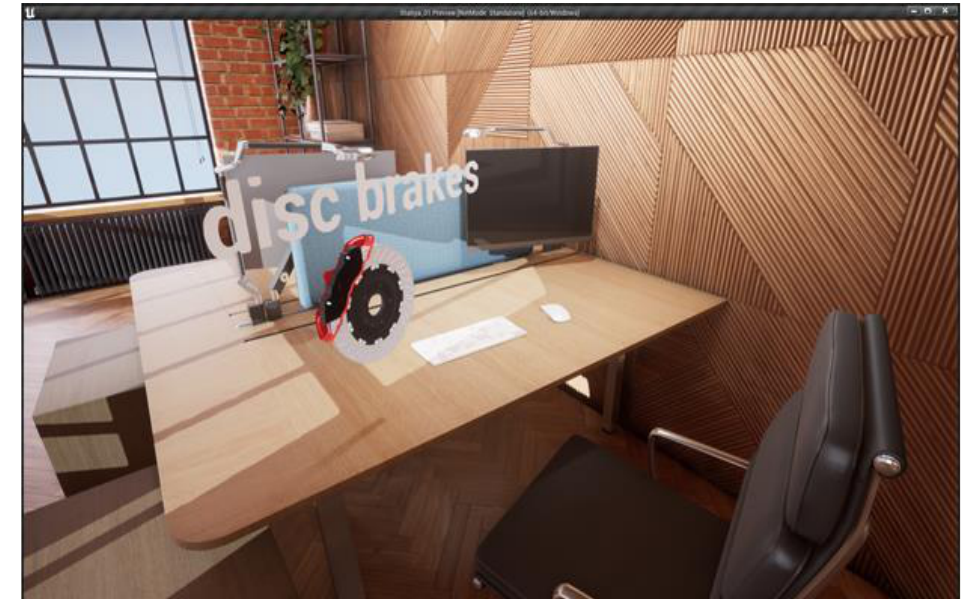
Figure 5. Screenshot of the environment of the object under study and its translation into English.